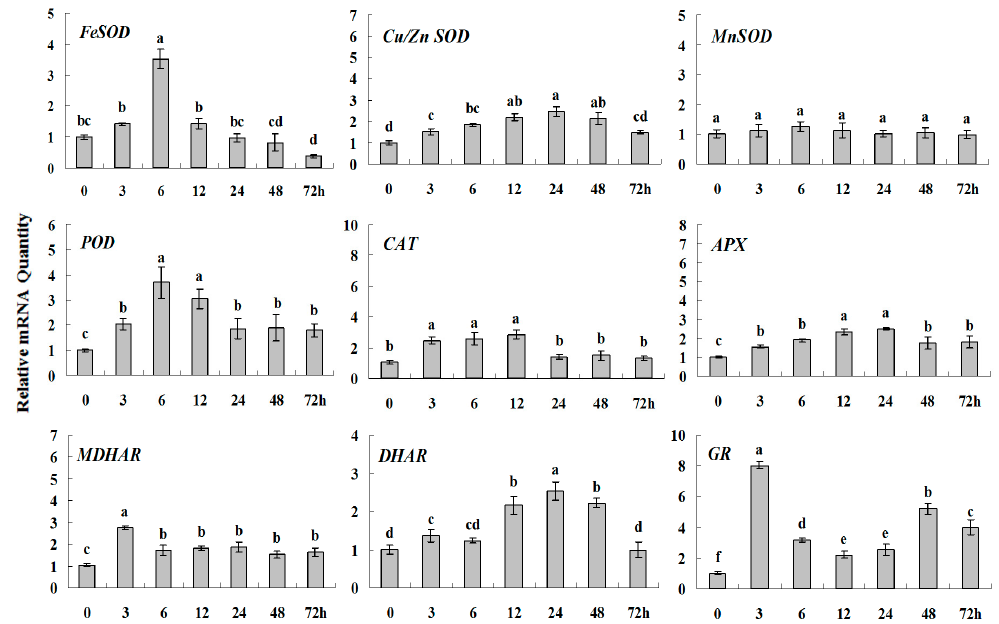
Figure 7. Quantitative real-time RT-PCR was used to analyze of ROS-scavenging enzyme genes expression treatment with ABA and normalized to β -actin . White clover leaves were sampled after 0, 3, 6, 12, 24, 48 and 72 h treatment. Data represent means of three replicates. Error bars representing standard errors and the different letters above the bars represent significant difference ( p < 0.05).